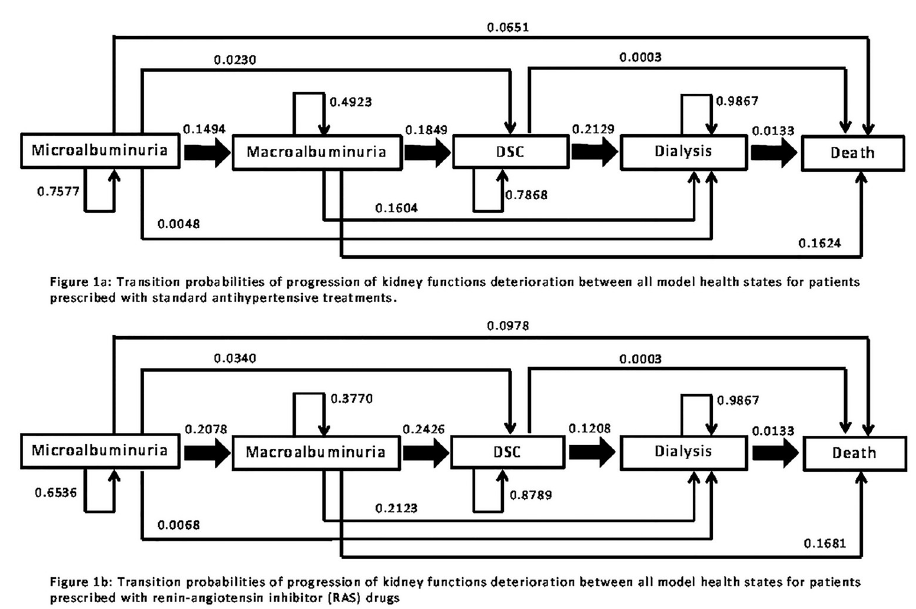
Fig 1. Transition probabilities of the progression of kidney function deterioration between all model health states. Fig. 1(a): For patients prescribed with standard antihypertensive treatments. Fig. 1(b): For patients prescribed with renin-angiotensin inhibitor (RAS) drugs. Microalbuminuria (MAU): 24-hour urinary albumin excretion [UAE] of 20–200 μ g/minute or 30-300mg/24 hour; Macro-albuminuria: 24-hour UAE of > 200 μ g/minute or > 300mg/24 hour; Doubling serum creatinine (DSC) from baseline; End-stage renal disease (ESRD) treated by dialysis; All-cause mortality.